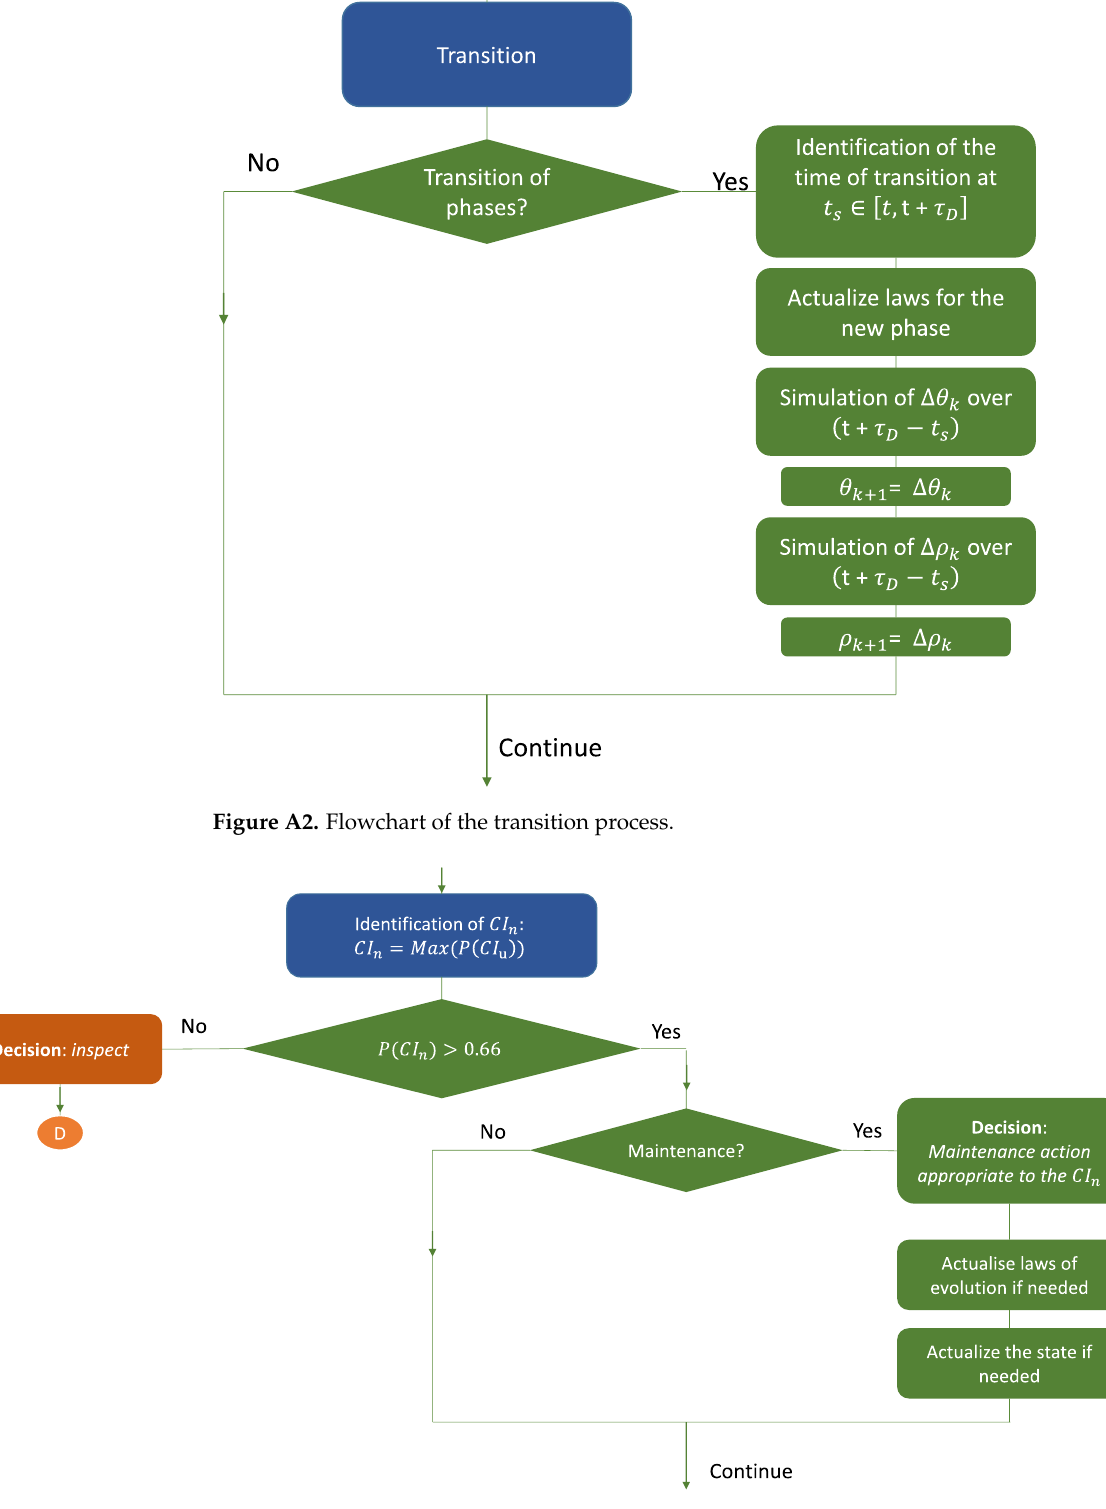
Figure A1. General flowchart of the proposed model.